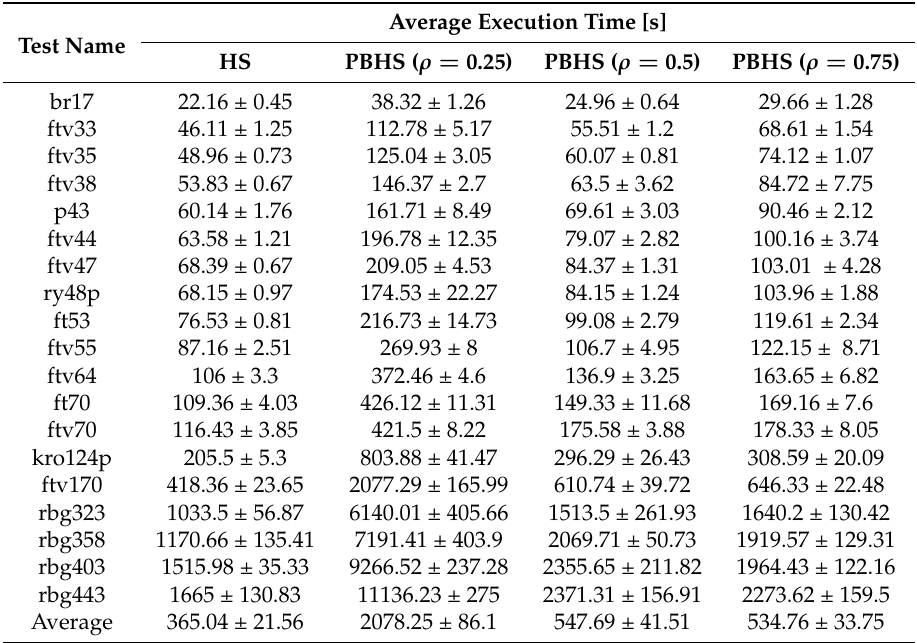
Table 4. Comparison of the execution time.